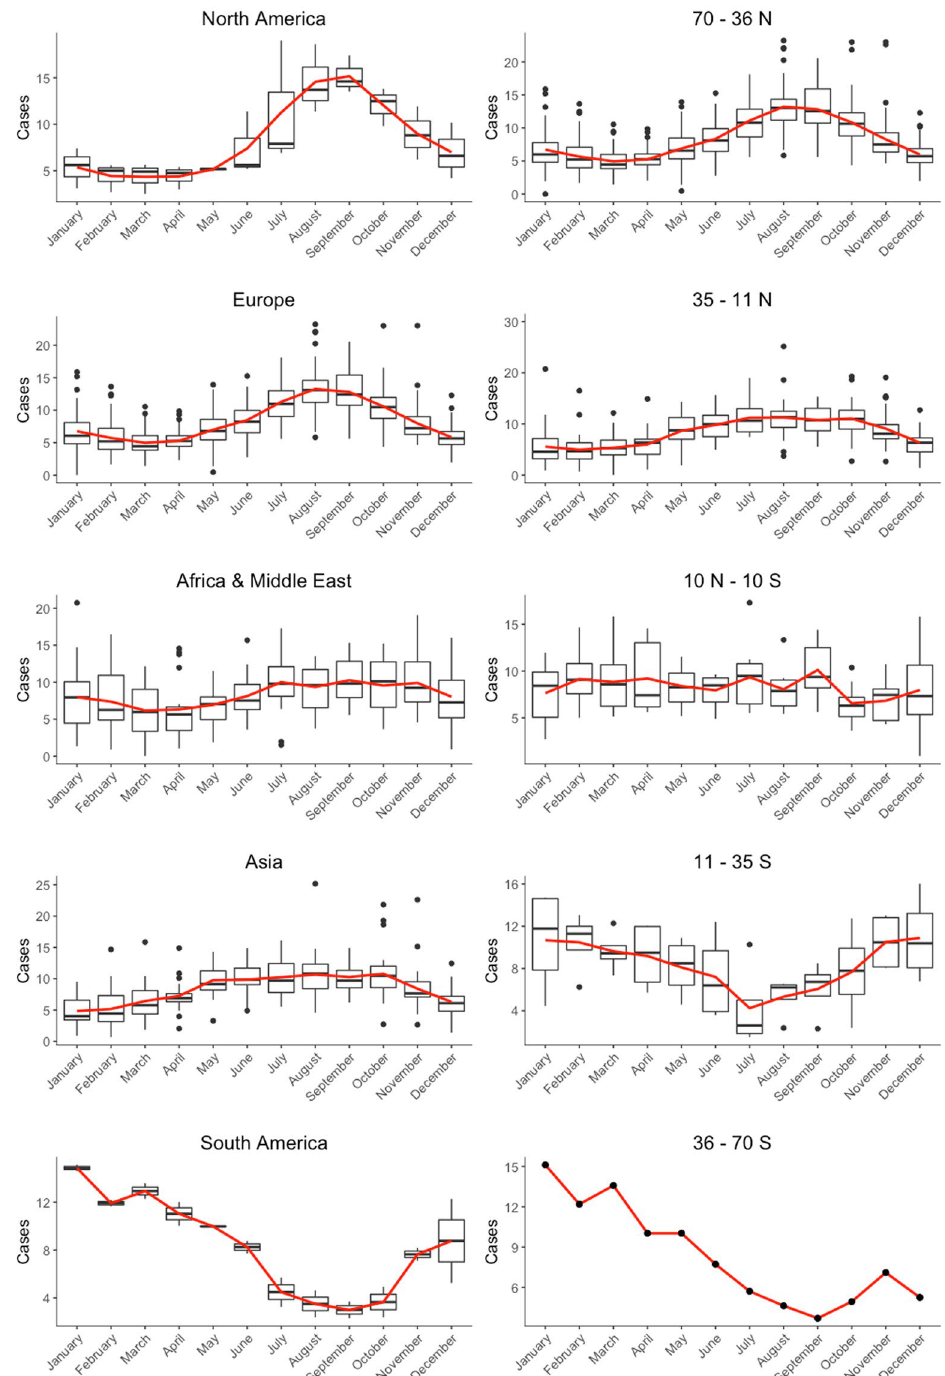
Figure 2. Seasonal dynamics of enteric and typhoid fever by continent and latitude. The boxplots show the percentage of cases of the different studies for each month of the year and the red line depicts the mean percentage of cases for each month of the